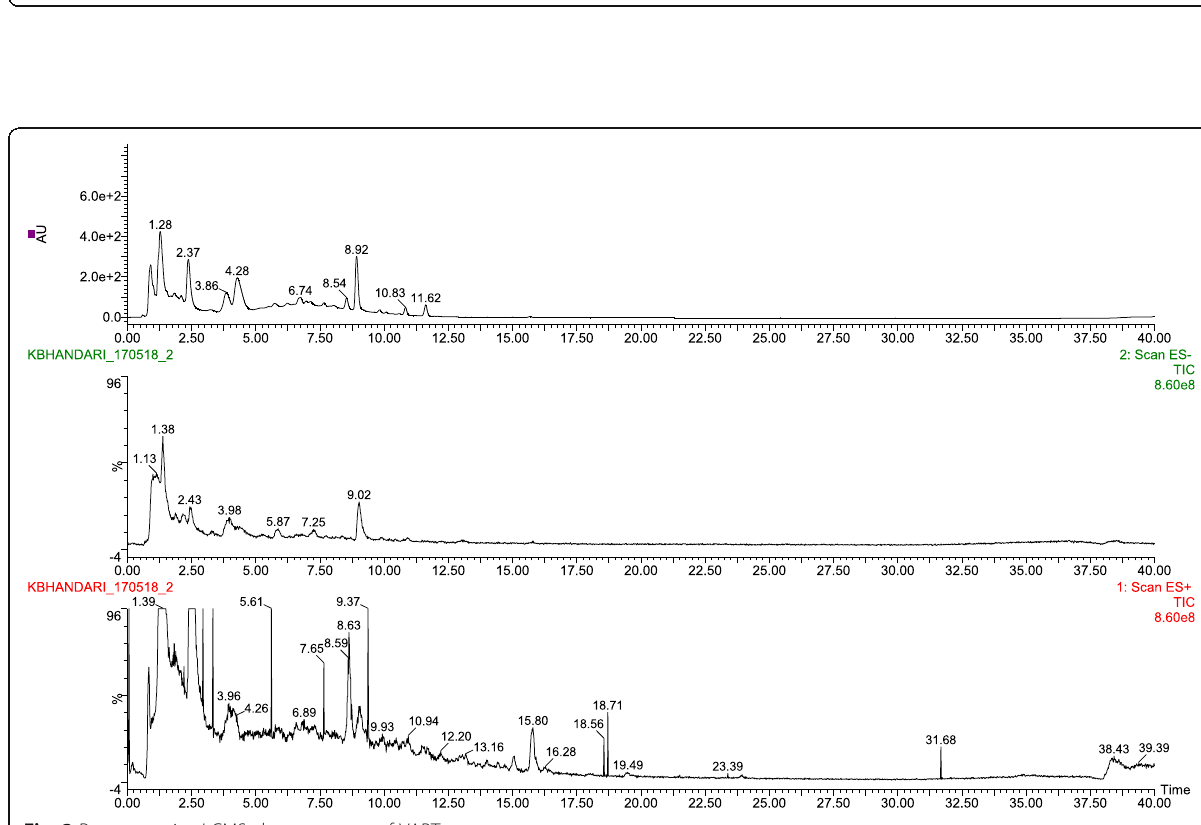
Fig. 2 Desirability ramp function graph